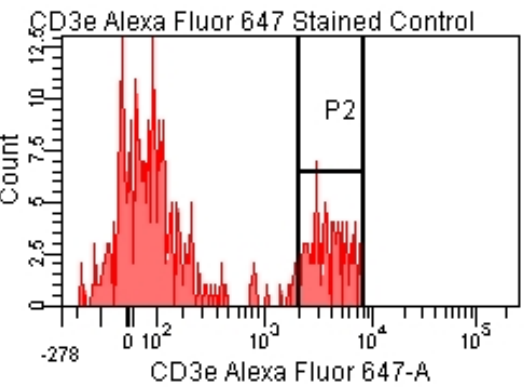
Figure 5. Labeled cell suspension—red laser stimulation.